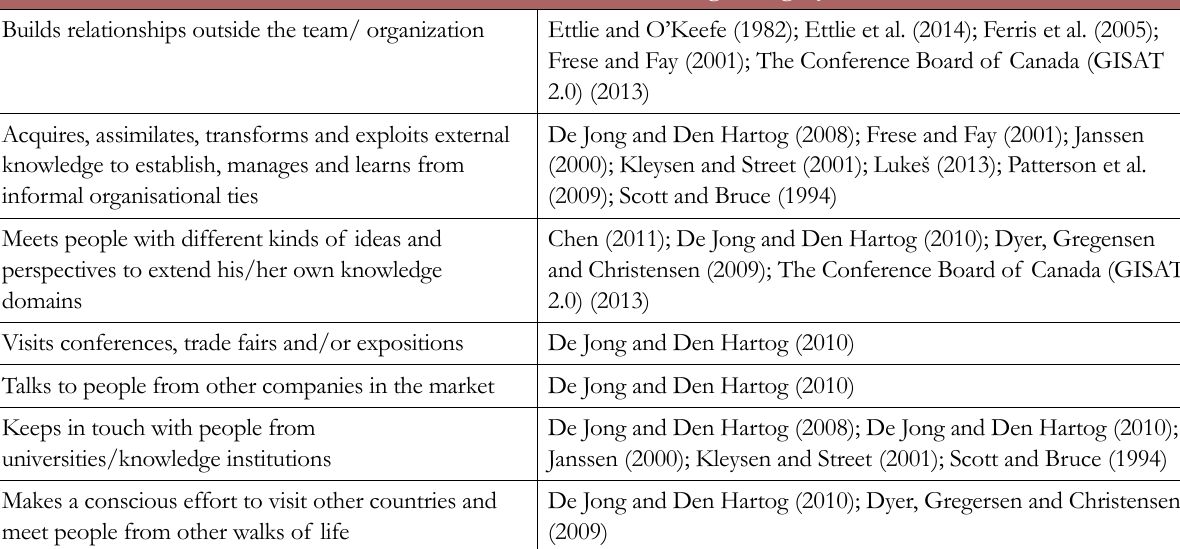
Table 21. Behavioural indicators showing “making contacts out of an organization”